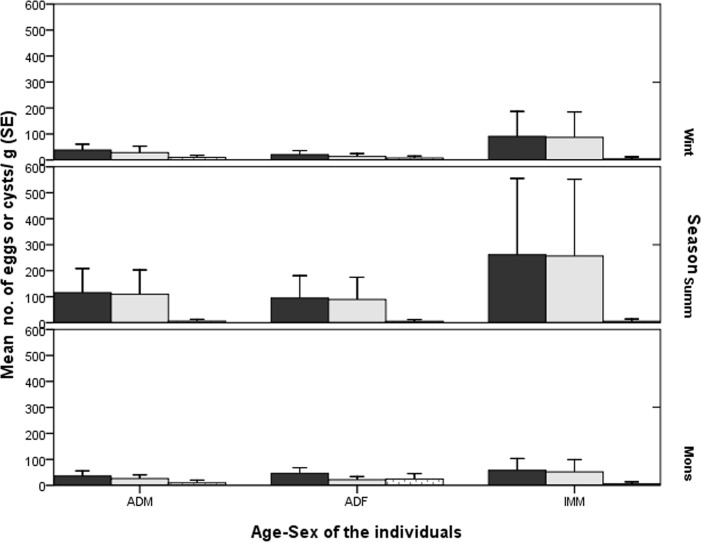
Mean egg/cysts load in fecal samples of different age-sex individuals of bonnet macaques in different seasons (dark gray: Overall load; light gray: Helminth load; dotted: Protozoan load).